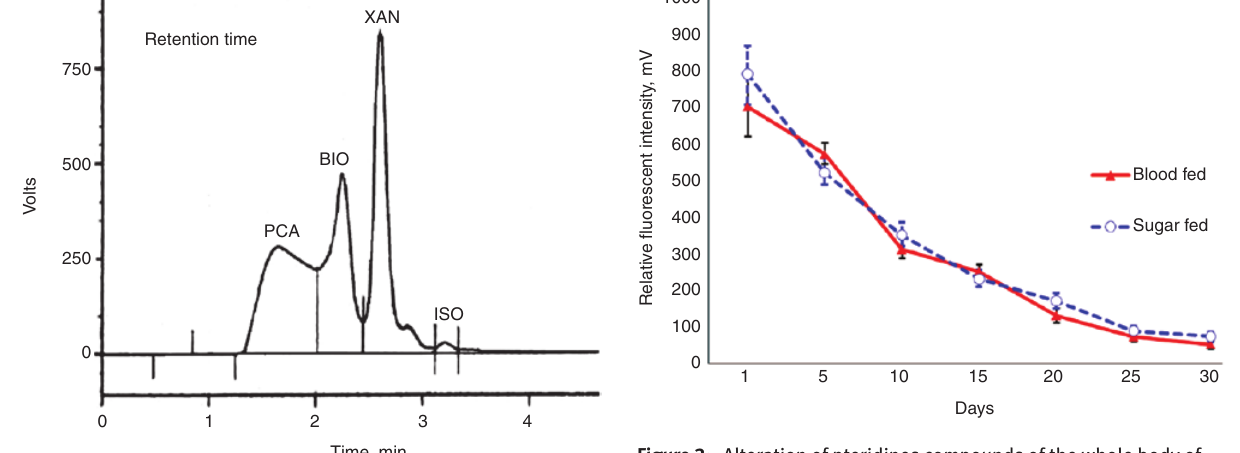
Figure 3: Alteration of pteridines compounds of the whole body of Anopheles staphensi females fed on blood and sugar during 30 days.